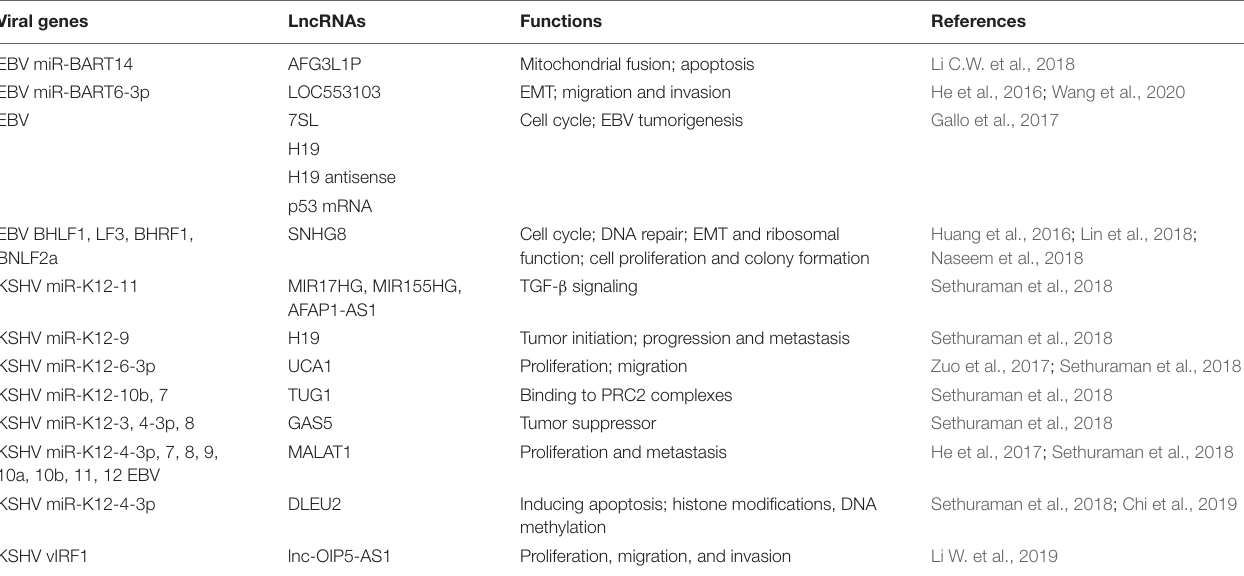
TABLE 1 | Cellular lncRNAs regulated by EBV and